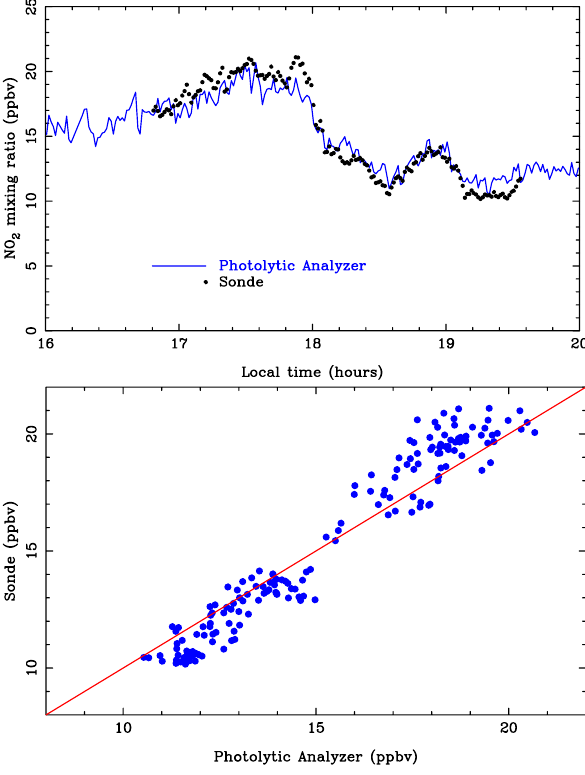
Fig. 10. Left: NO 2 concentration measurements by the NO 2 sonde (black dots) compared with those by the M200E photolytic analyser (blue line). Measurements were taken during the evening rush-hour in Bilthoven, The Netherlands. Right: scatter diagram of the same